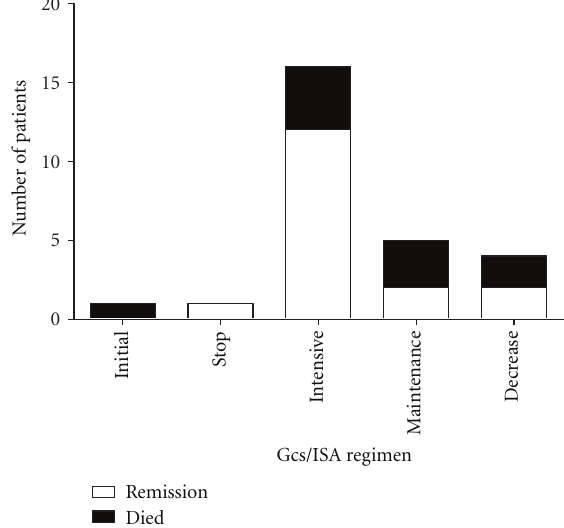
Figure 2: Treatment regimen and outcome of the SLE-related AP. those with abdominal pain, and appropriate glucocorti- costeroid treatment is beneficial for a better therapeutic outcome in the majority of